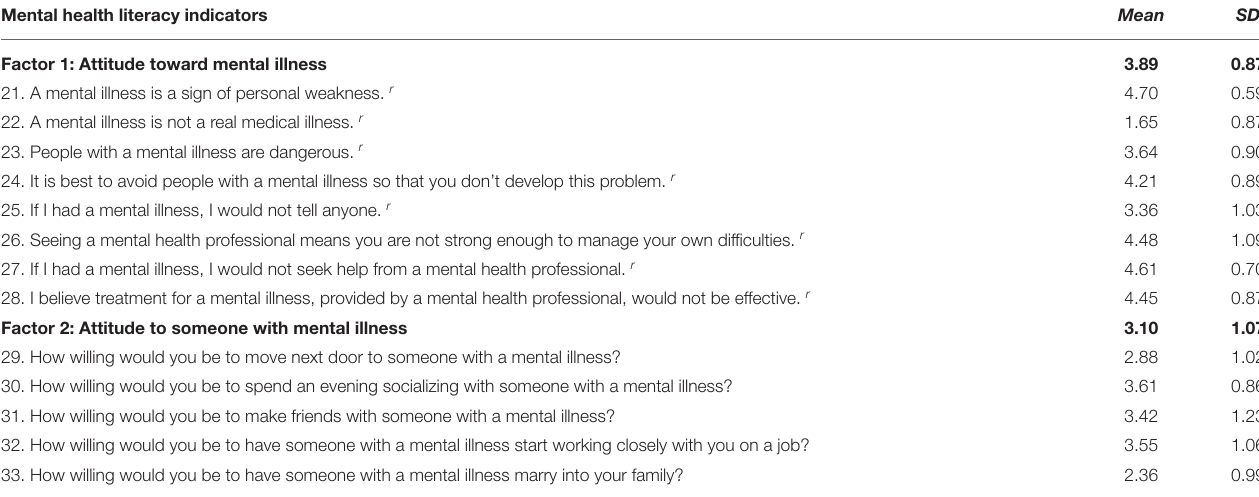
TABLE 5 | Mental health literacy of Saudi university students ( N = 339). Mental health literacy indicators Factor 1: Attitude toward mental illness